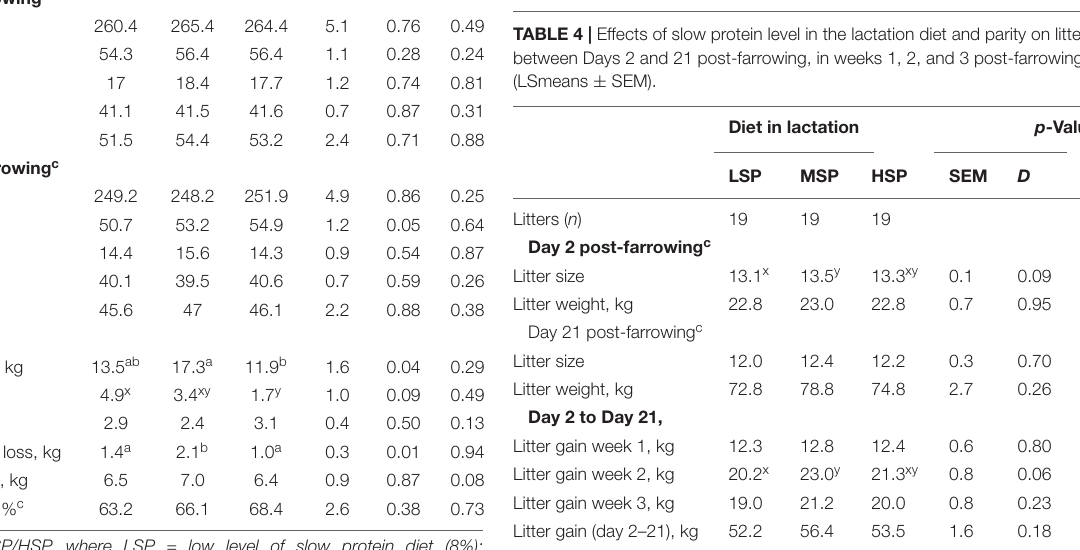
TABLE 3 | Effects of slow protein level in the lactating sow diet on sow body condition parameters on Days 2, 21, and 2–21 post-farrowing (LSmeans ± SEM). Diets in lactation